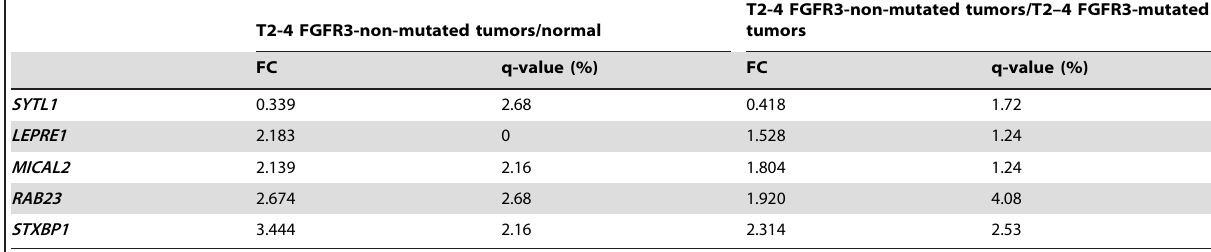
Table 4. Genes specifically deregulated in one of the two pathways of bladder cancer